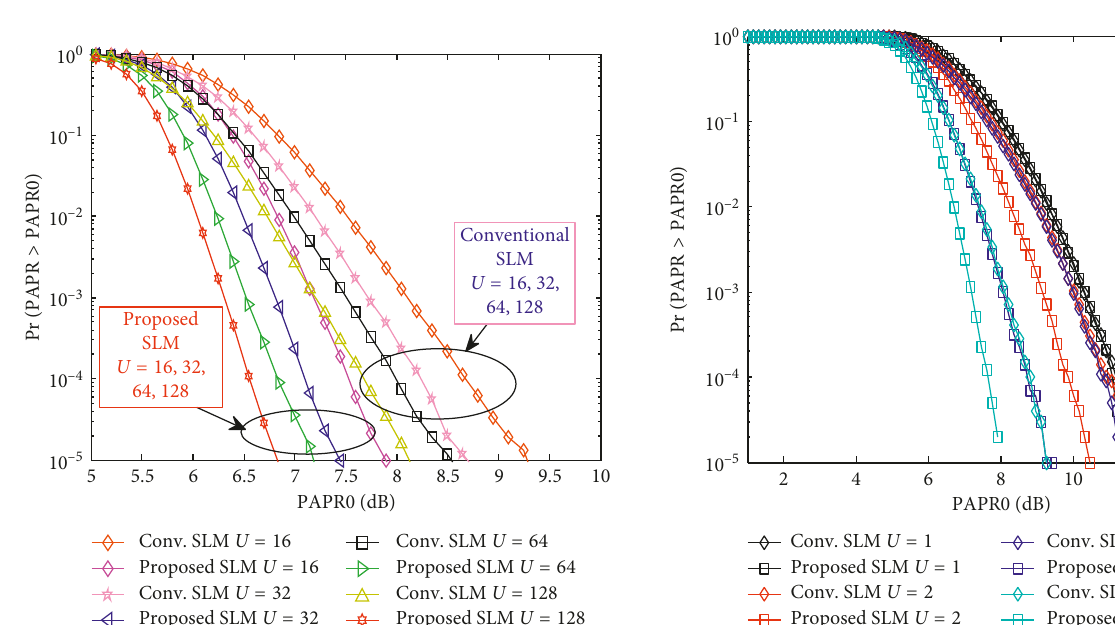
Figure 2: Comparison of SLM given in [5] with proposed SLM for U � 1, 2, 4, and 8, N � 128, and